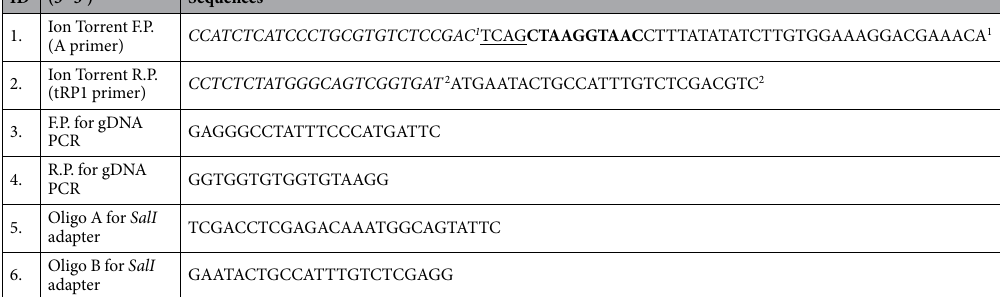
Table 1. Oligonucleotides for shRNA library preparation (Integrated DNA Tech.). F.P.: Forward primer, R.P.: Reverse primer, A sequence 1 , Key, Barcode ( one example ), Framework 1 , P1 sequence 2 , Complementary to adapter 2 .